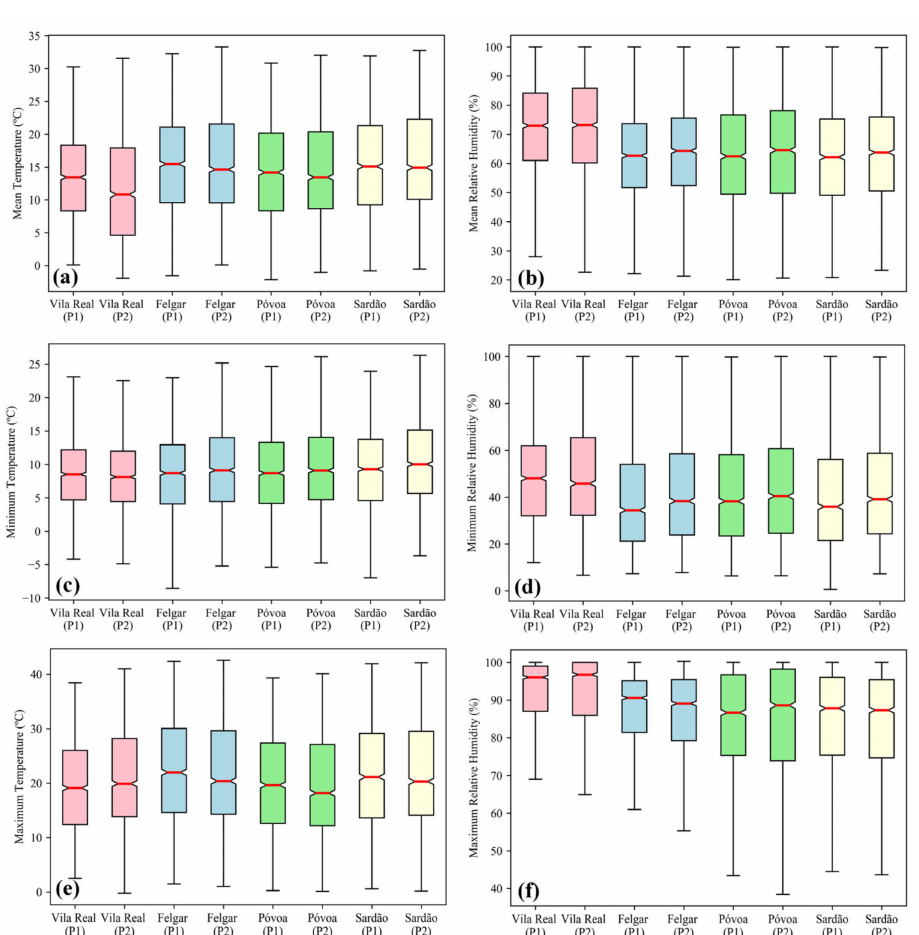
Figure 5. Boxplots of daily temperature (left panel) and daily relative humidity (right panel) for the AWS network stations and Vila Real control station for the period 2011–2015 (P1) and 2016–2020 (P2): ( a , b ) mean values; ( c , d ) minimum values; and ( e , f ) maximum